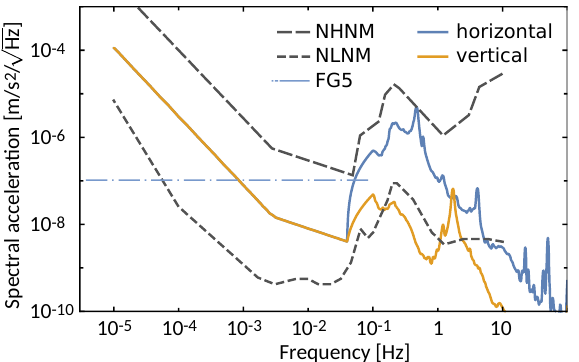
Figure A2. Extrapolation of spectral seismic acceleration below 0.1Hz using the ‘new high noise model’ (NHNM) [246], scaled to fit the measured vertical acceleration at 0.1Hz. We also indicate the noise level of FG-5 data recorded at a nearby station that can be used to correct our pressure